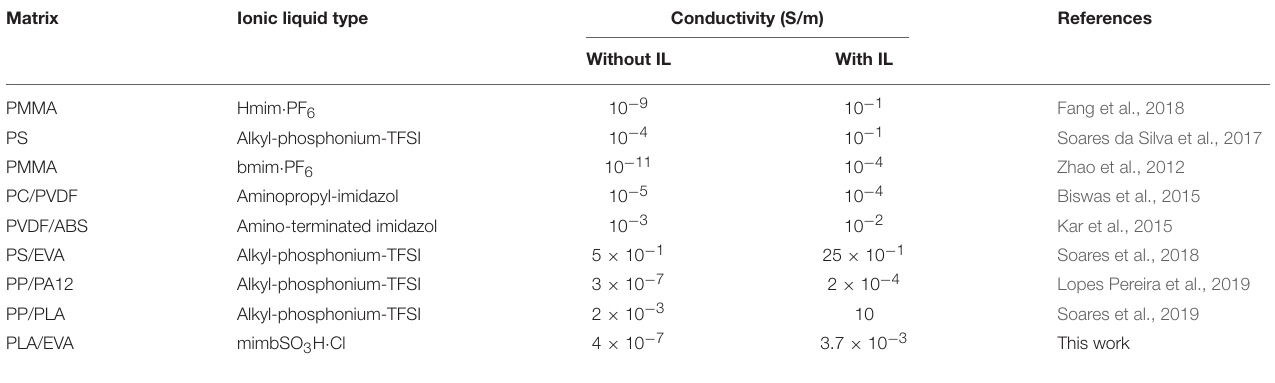
TABLE 4 | Electrical conductivity of heterogeneous polymer blends loaded with 1% of CNT-IL filler.